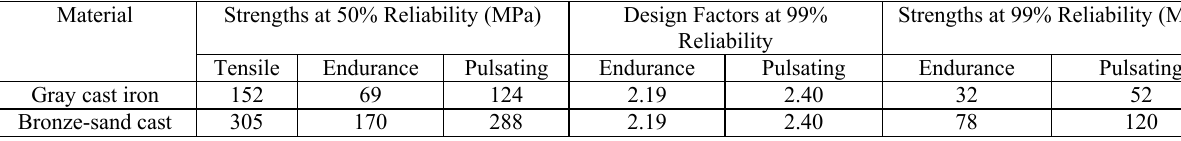
Table 7: Pulsating Strength Based on Experimental Tensile and Endurance Strengths Material